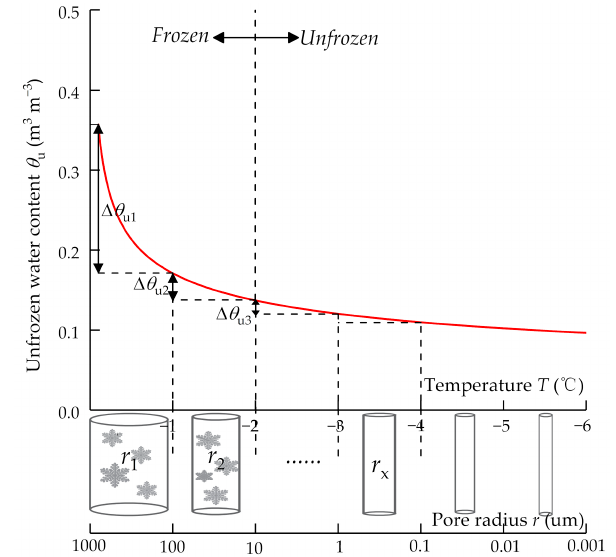
Figure 3. Scheme of a physical approach to determine the pore size distribution of frozen soil.